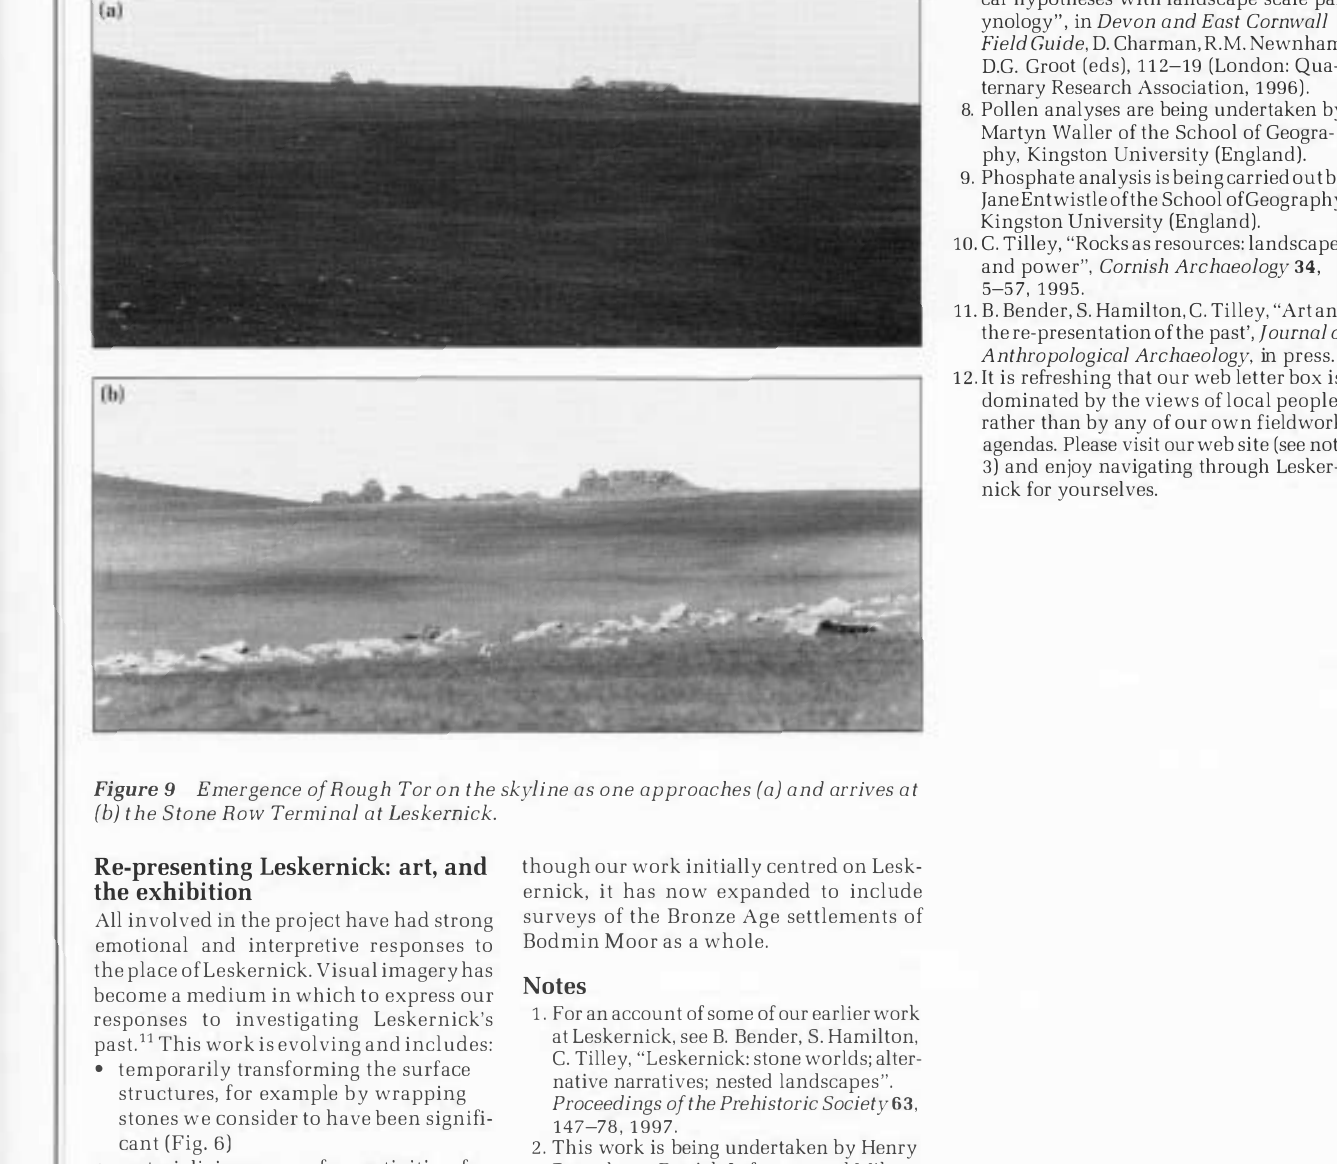
Re-presenting Leskernick: art, and the